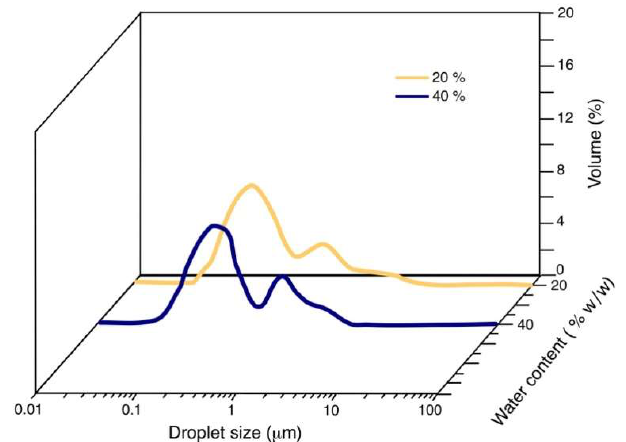
Figure 4. NE’s drop size distribution as a function of water content for the dilution line S/O 70/30.